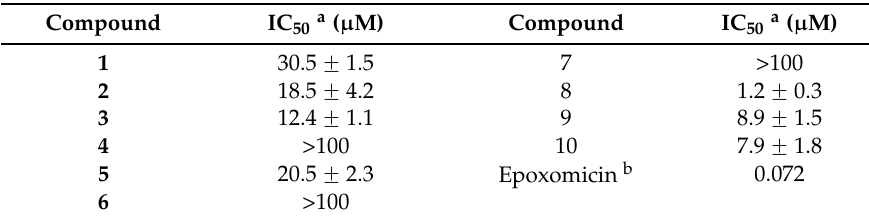
Table 1. 20S proteasome inhibitory activities of compounds 1 – 10